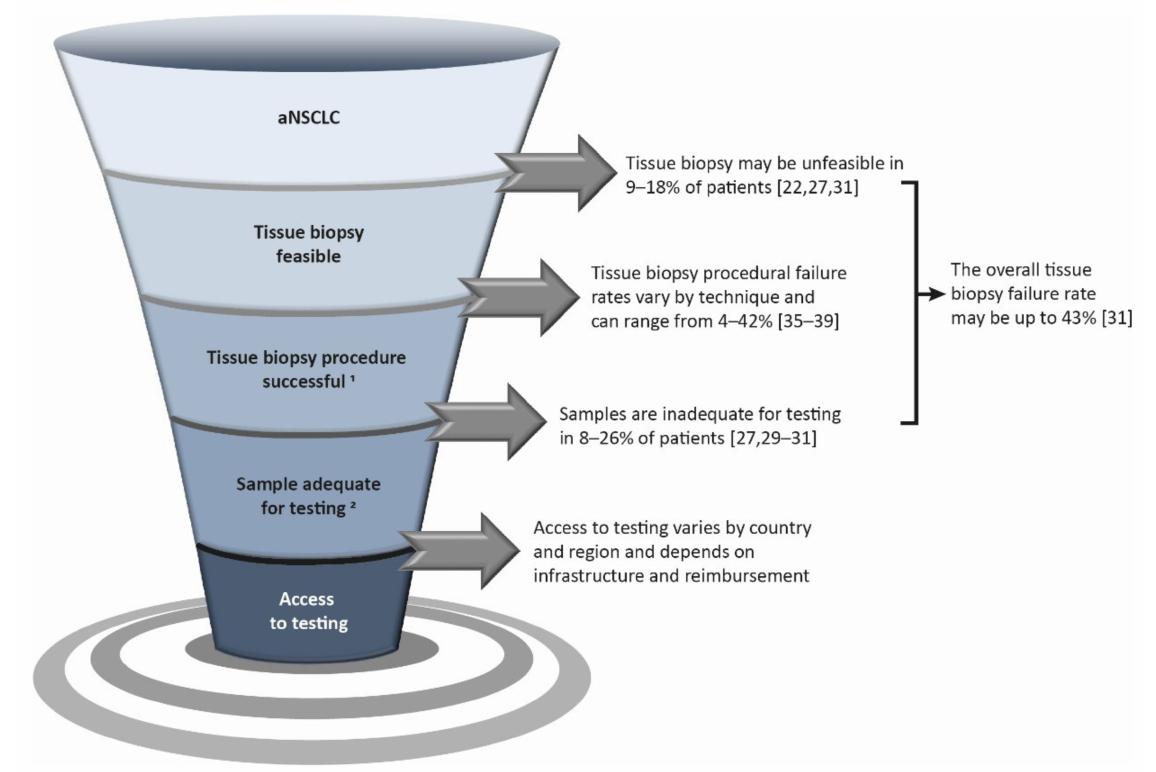
Figure 1. Reasons why patients miss out on biomarker testing/molecular diagnosis from tissue biopsy. Abbreviation: aNSCLC, advanced non-small cell lung cancer. 1 i.e., tissue sample successfully extracted from target lesion. 2 Molecular diagnosis and/or histological diagnosis